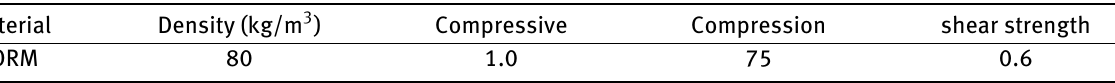
Table 2: The experiment parameter of ArmaFORM PET